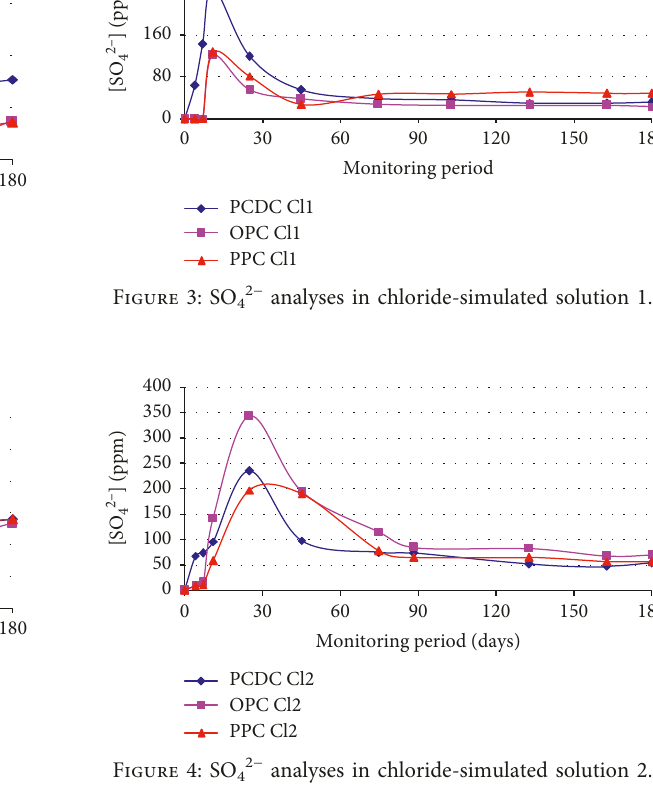
Figure 2: Cl analyses in chloride-simulated solution 2. −